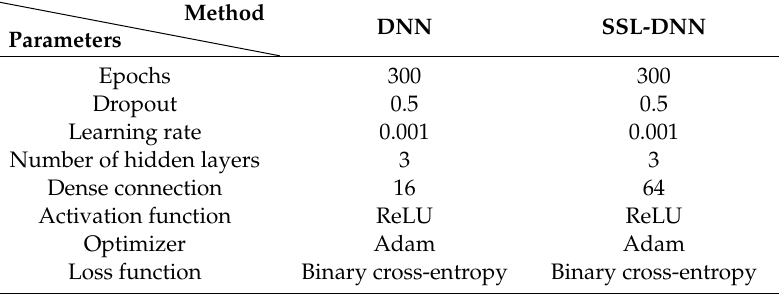
Table 2. Multi-collinearity and IGR among impact factors. Table 3. Parameter settings of DNN and